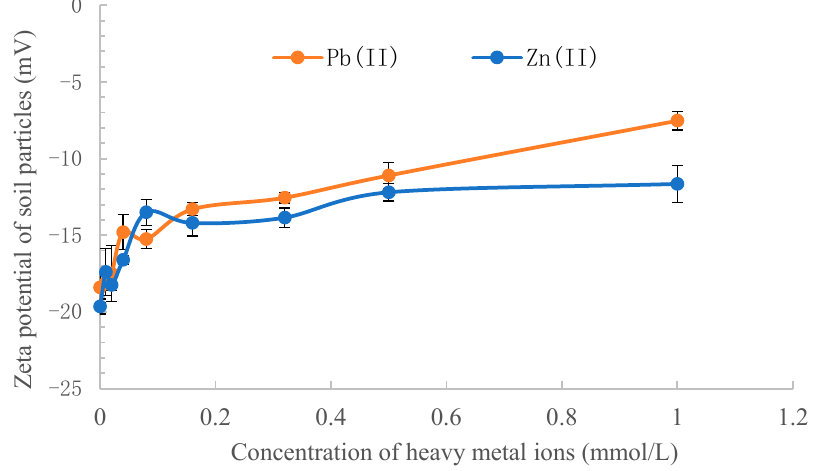
Figure 4. Effect of Pb(II) and Zn(II) concentration on the zeta potential of soil particles.